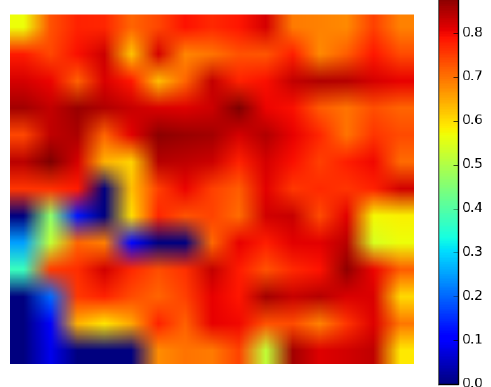
Figure 8. Kappa index obtained on